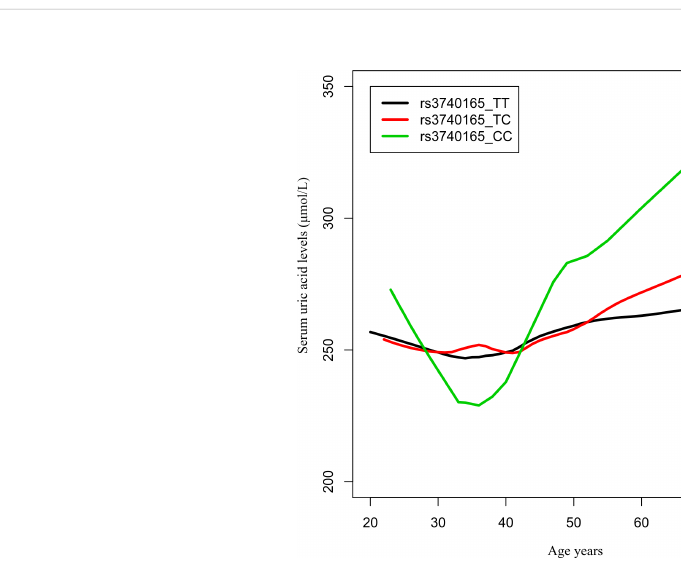
FIGURE 2 Age − urea acid curves of rs3740165 genotypes. The changes in serum uric acid in three different genotype carriers with age